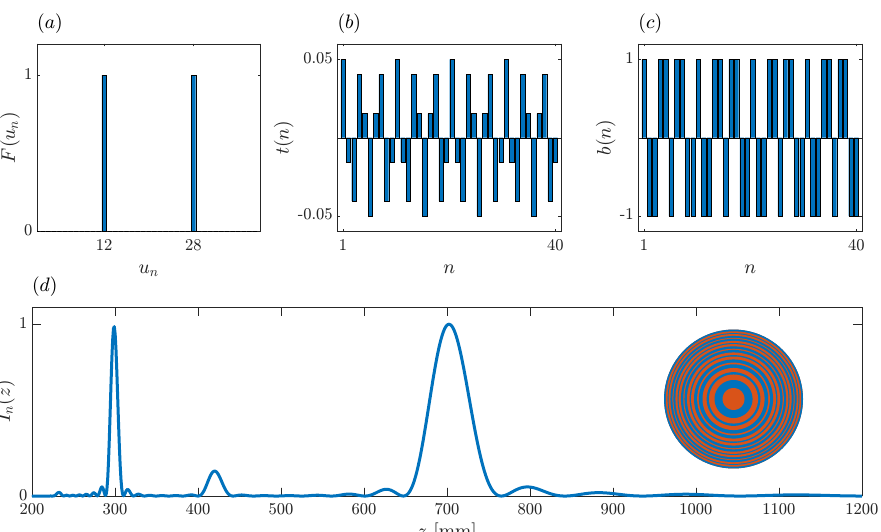
Figure 12. Example of the design of a bifocal ZP with foci locations at z 1 = 300 mm and z 2 = 700 mm. ( a ) Focusing profile sequence. ( b ) Transmittance sequence. ( c ) ZP binary sequence. ( d ) ZP bifocal normalized focusing profile. Inset: Bifocal ZP